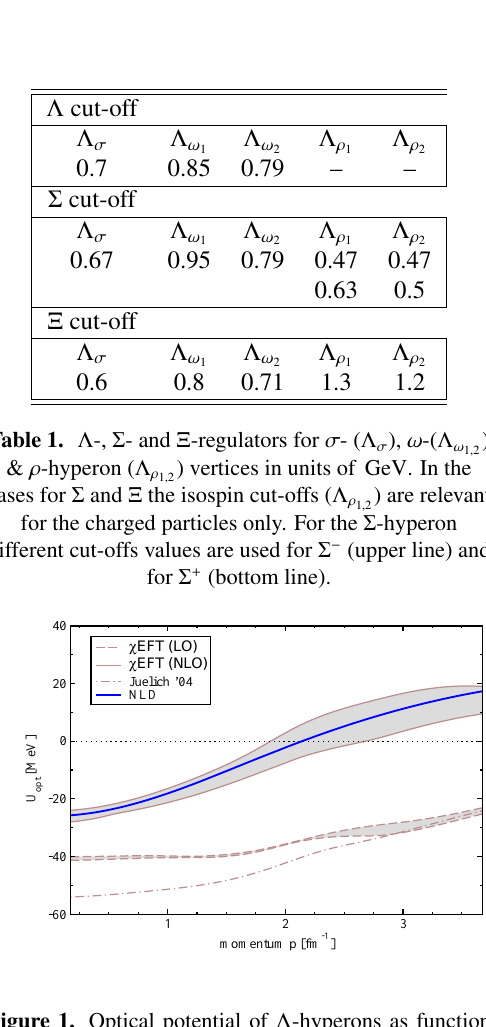
Figure 4. Same as in Fig. 3, but for the Σ